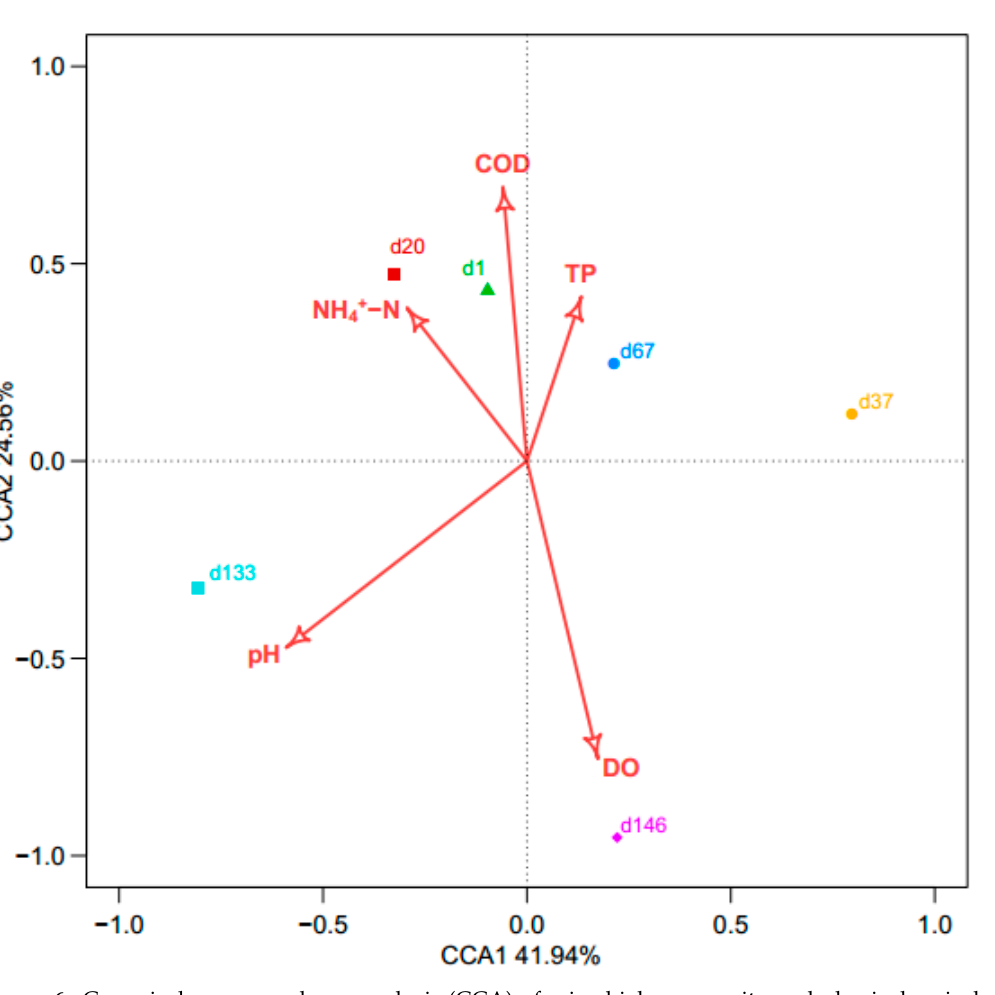
Figure 6. Canonical correspondence analysis (CCA) of microbial community and physiochemical properties in the river.